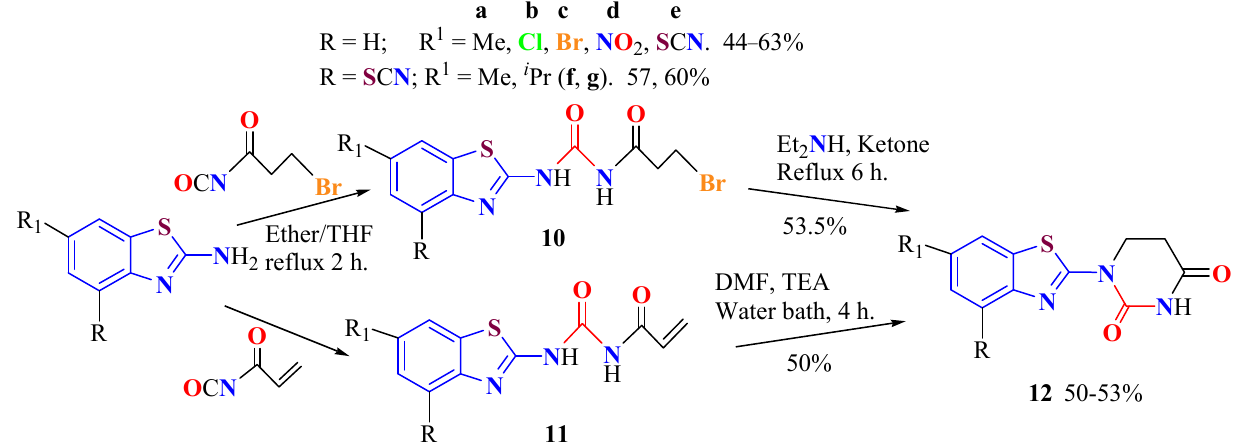
Figure 2. Substituted UBTs 9 from 2ABTs and alkyl-, -aryl-isocyanates, and carbamoyl chloride. In 1973, 4,6-disubstituted- β -bromo-propyl-UBTs 10a – g and 4,6-disubstituted-ethenoyl UBTs 11a – g were prepared from the reaction of 4,6-disubstituted-2ABTs with β -bromo-propionyl-isocyanate to be cyclized to produce l-(4,6-disubstituted-benzothiazol-2-yl) dihydrouracils 12 , Scheme 3 [118]. A mixture of ether/THF was used for 10a , f , g or THF for 10b – e . The reaction mixture refluxed for 2 h. All compounds were shown to have antibacterial, antifungal, and antiprotozoal in vitro effects. The minimal inhibition concentration of 6-thiocyanate- β -bromo-propionyl-UBT 10f was 50 µ g/mL for all tested organisms, which represent a high efficiency.